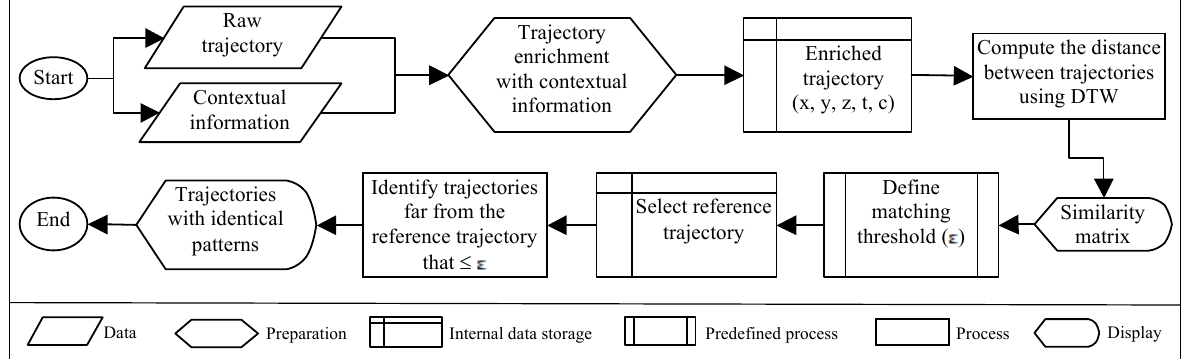
Figure 1. Methodology for contextualizing similarity measure and pattern discovery for trajectories